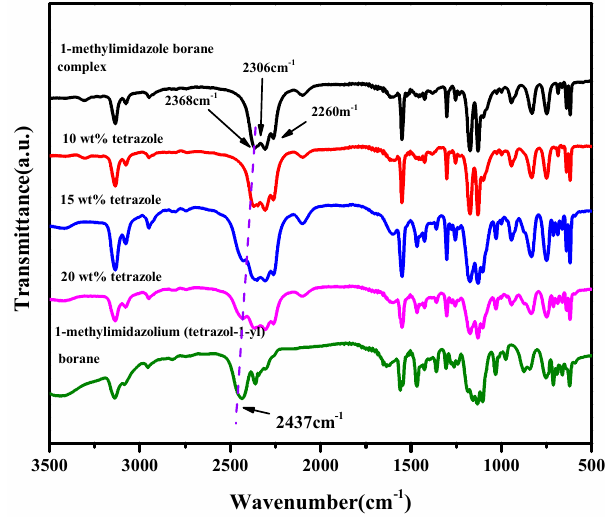
Figure 6. FT-IR of tetrazole with different mass ratios in 1-methylimidazole borane complex and (1-methylimidazolium)(tetrazol-1-yl) borane.